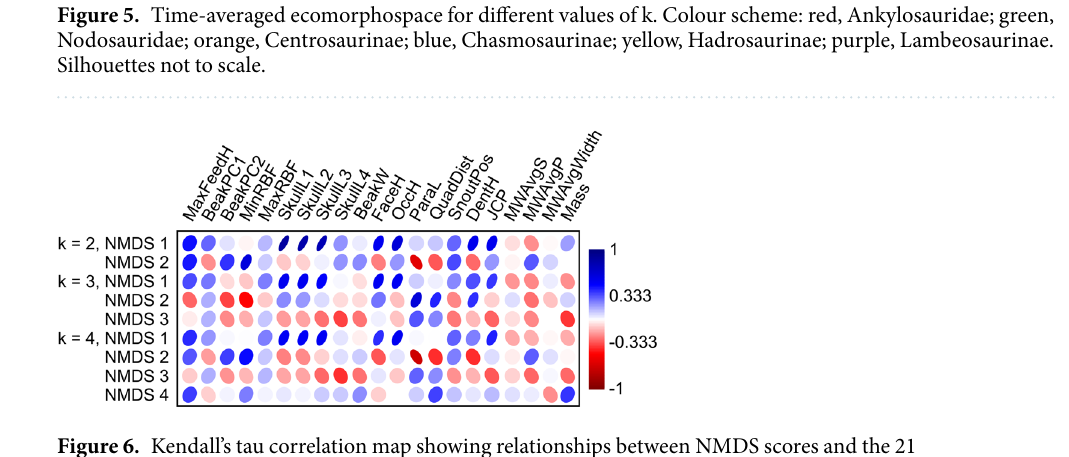
Figure 6. Kendall’s tau correlation map showing relationships between NMDS scores and the 21 ecomorphological variables used in this study. Abbreviations after Table 1.